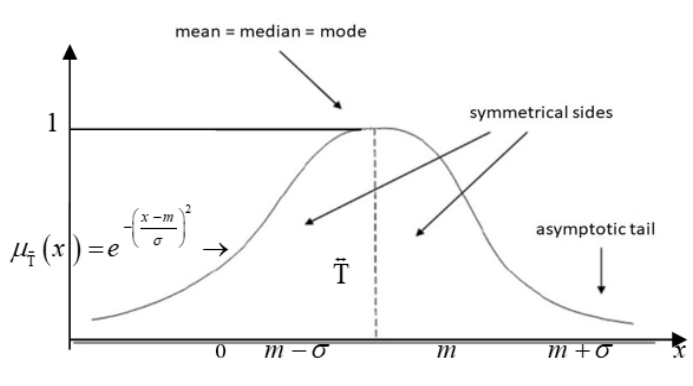
Fig. 1. Gaussian membership